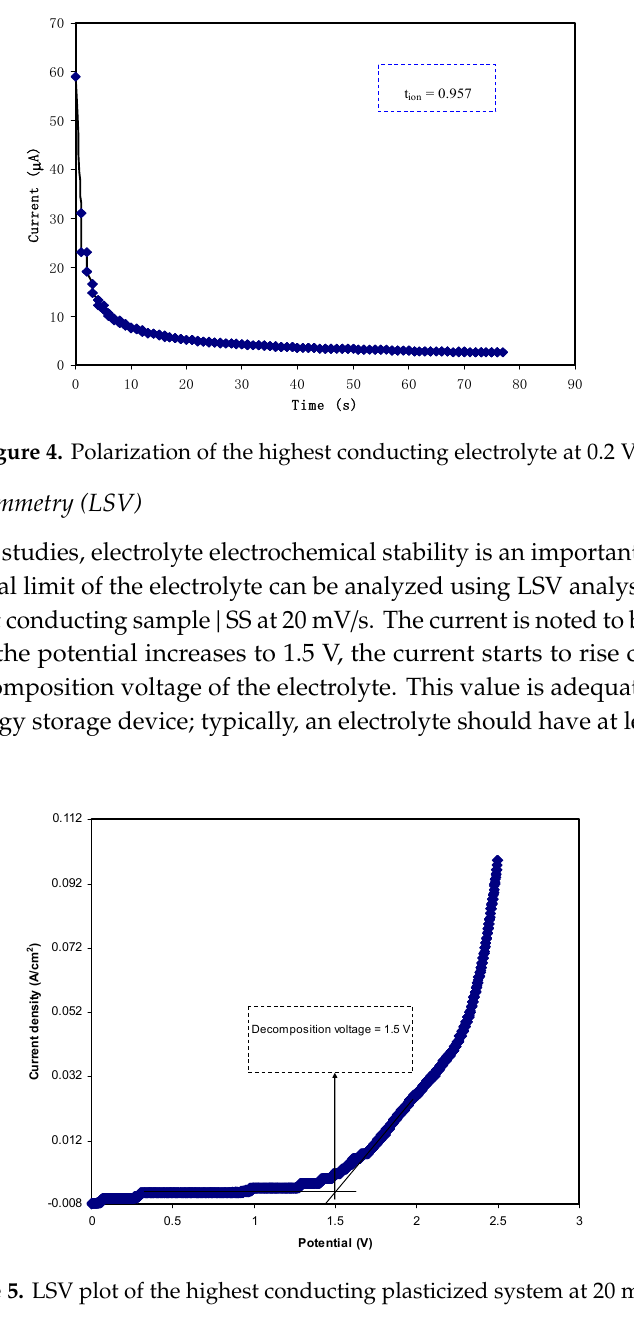
Figure 5. LSV plot of the highest conducting plasticized system at 20 mV/s.